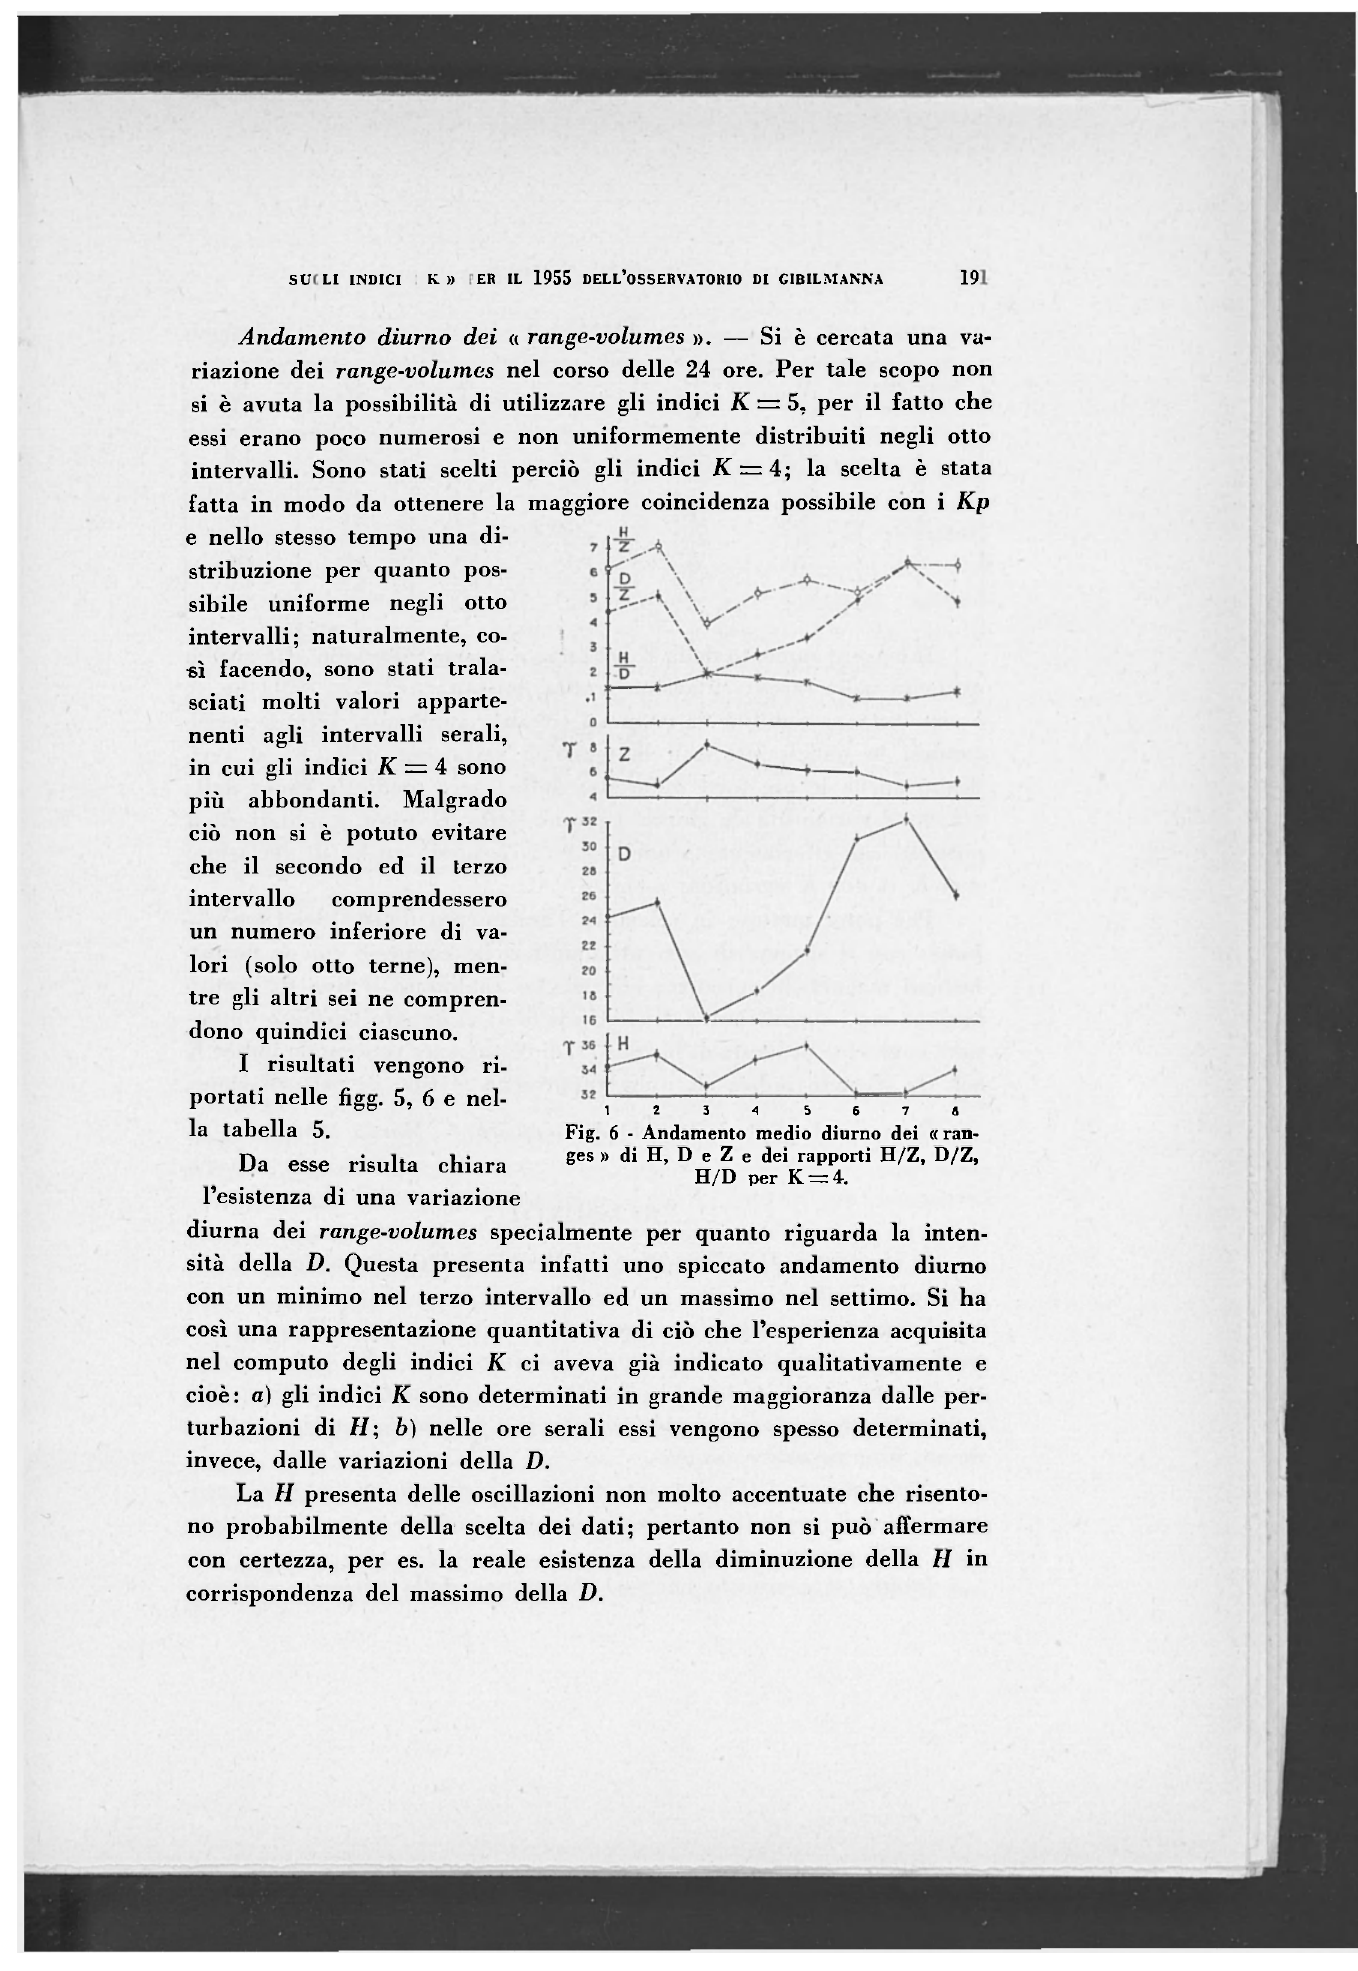
Fig. 6 - Andamento medio diurno dei « ran- ges » di H, D e Z e dei rapporti H/Z, D/Z, H/D per K =